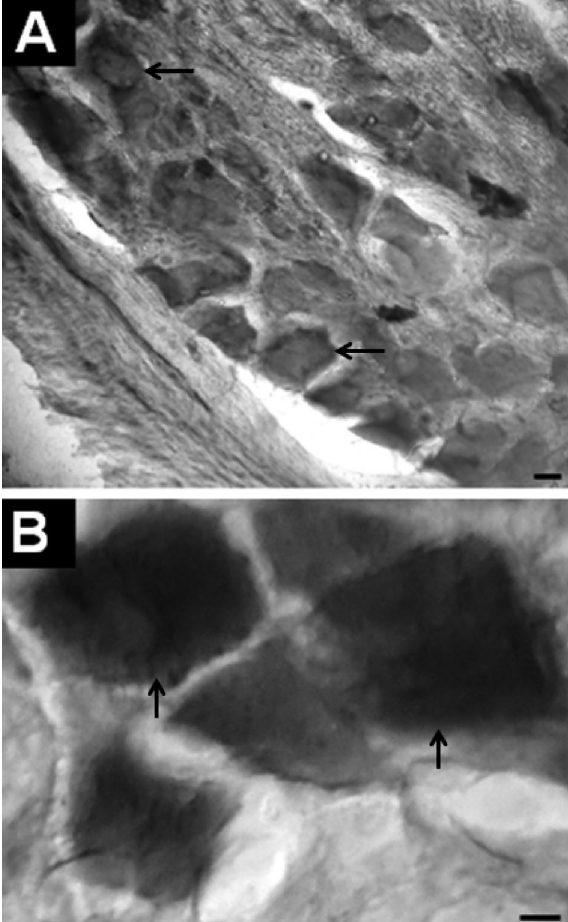
Figure 5. Serotonin- ( A ) and Glut3-like ( B ) immunoreactivity in a medium neuron of the dorsal root ganglion from a naive frog. Scale bars: A = 20 m m; B = 40 m